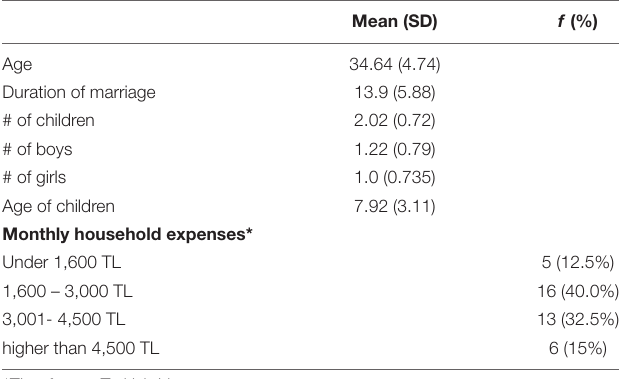
TABLE 1 | Socio-demographic characteristics of participants ( N = 43).